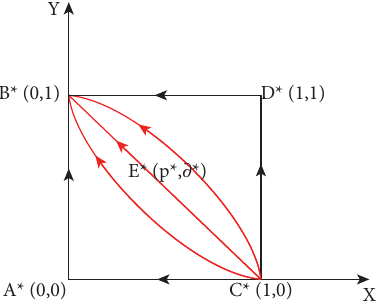
Figure 2: Copying dynamic phase diagram of the local government and